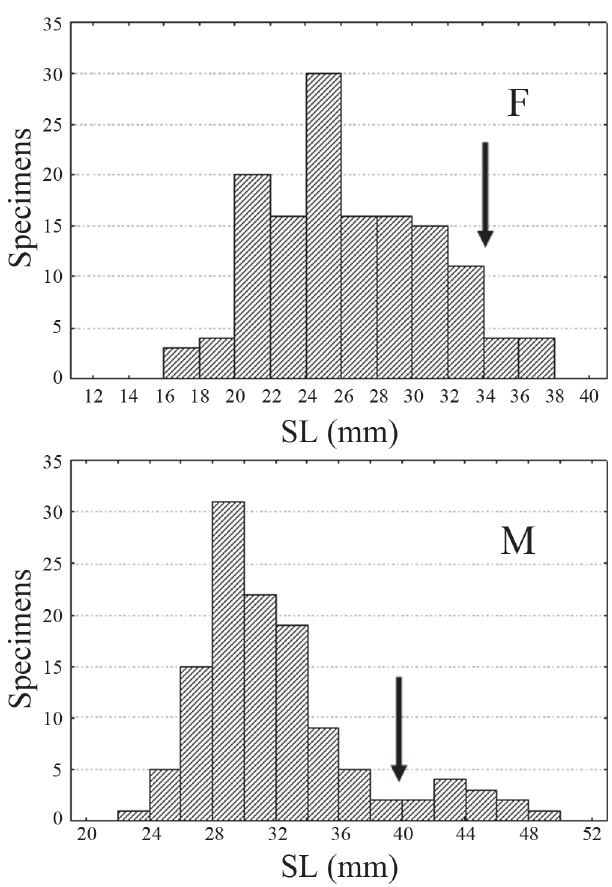
Fig. 2. Size distribution of individuals analyzed of Austrolebias quirogai . Arrows indicate size above which there is little or no reduction in squamation patterns; F. females, M.